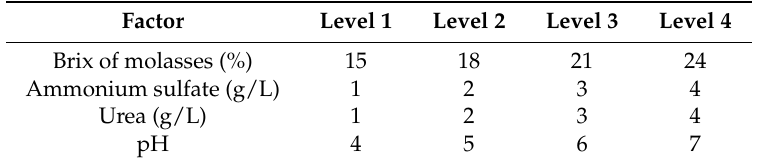
Table 1. Selected four factors of the medium and their levels for the design of experiments by the Taguchi method.